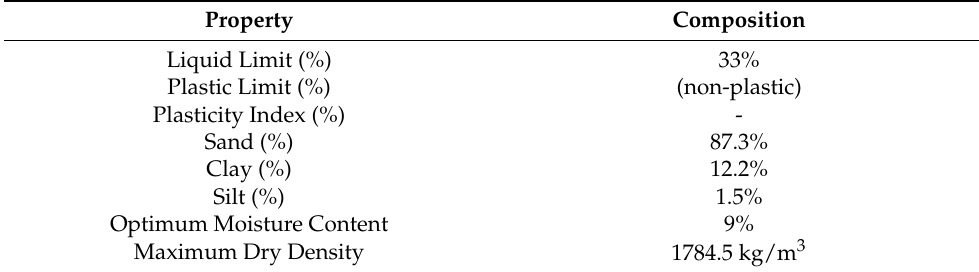
Table 1. Physical properties of